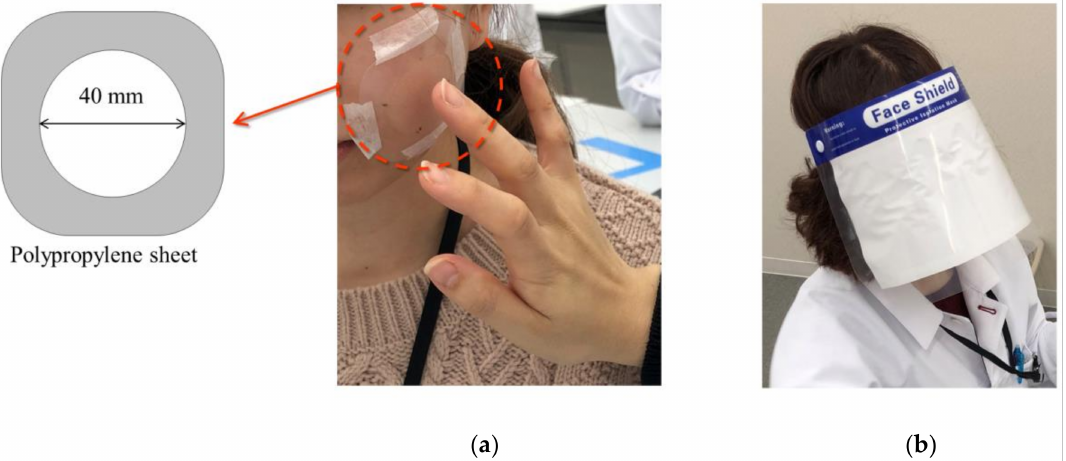
Figure 1. Images of the assessor and examinee during the experiment. ( a ) Examinee and evaluation area. ( b )